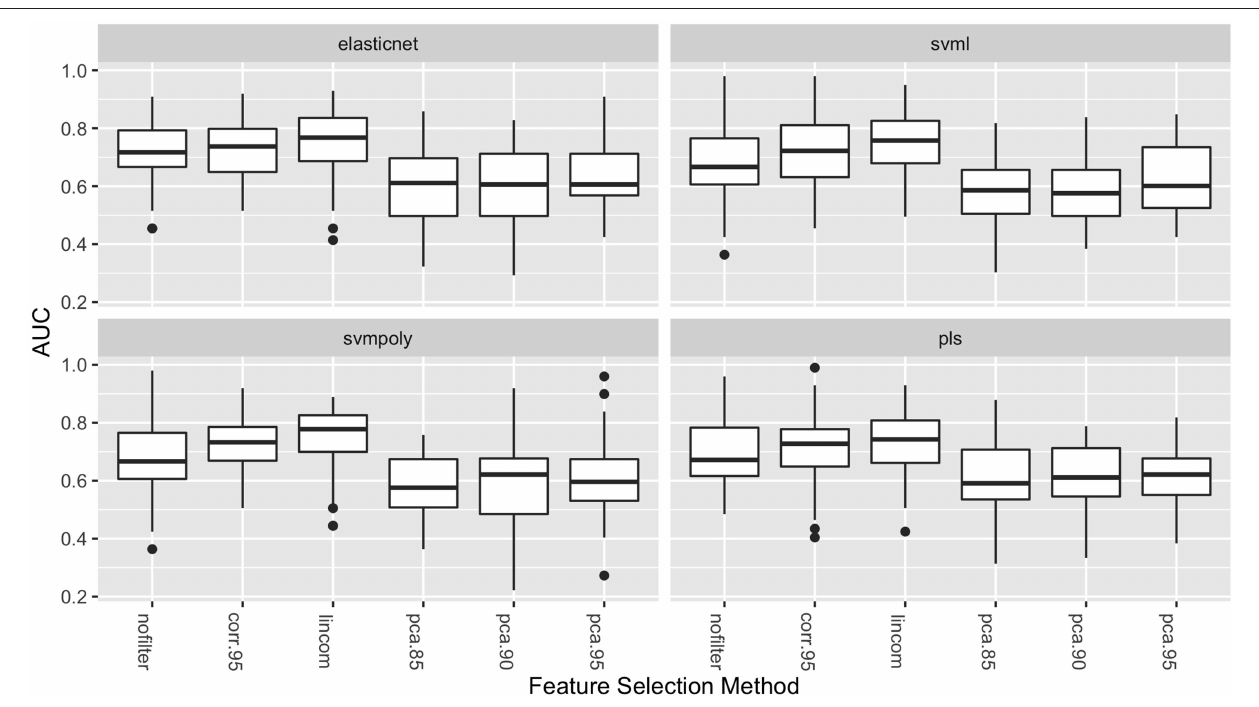
FIGURE 2 | Boxplots of AUC values (over the 50 repeated cross-validation testing sets) for each feature selection method for the four best-performing classifiers.